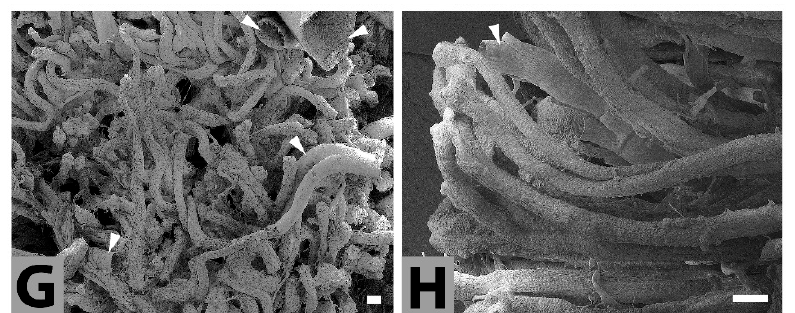
Figure 1. Scanning electron microphotographs of T. giganteus compound eye. ( A )—Part of the compound eye. ( B , C )—The regular and irregular shapes of facets, respectively. ( D )—Dorsal view to the ommatidia after removing of the lenses. Black arrows depict the retinula cells and black stars the pigment cells. ( E )—The cross section through the compound eye containing ommatidia with biconcave lenses, retinula cells, pigment cells and the bare axons extending from the rhabdoms. ( F )—The inner surface of the compound eyes covered by basement membrane with extending optical fibers (white arrows) where the axonal bundles are surrounded by the sleeve of supporting cells. ( G )—Tangle of muscles and tracheas (arrowheads) intertwine between the optical bundles and fulfil the inner hollow of the compound eyes. ( H )—The detail image of a few muscle bundle and tracheas (white arrowhead). Scale bar: 100 μ m.